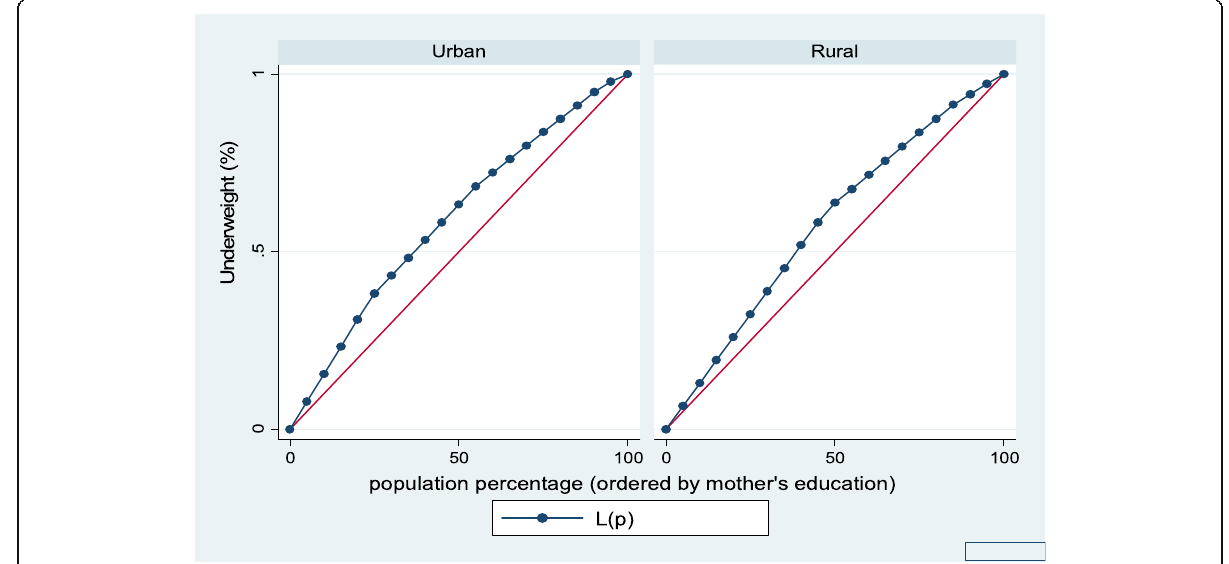
Fig. 9 Urban-rural Lorenz curve for underweight